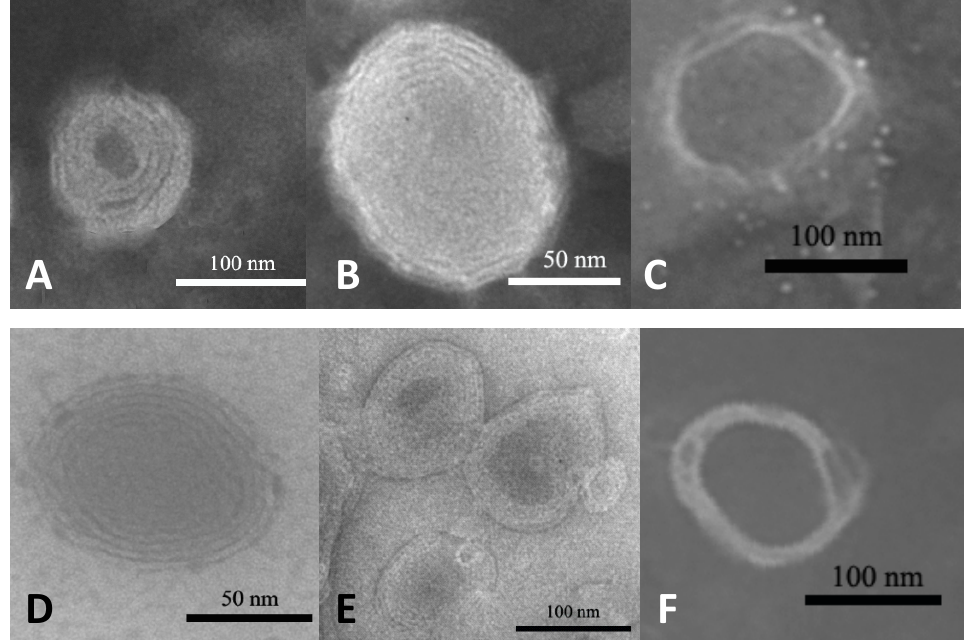
Figure 1. Negative electron transmission micrographs of rifampicin-loaded liposomes prepared with 30 or 60 mg/mL of phosphatidylcholine ( A ) PC30; ( B ) PC30 Chol; ( C ) PC30 Chol OA; ( D ) PC60; ( E ) PC60 Chol; ( F ) PC60 Chol